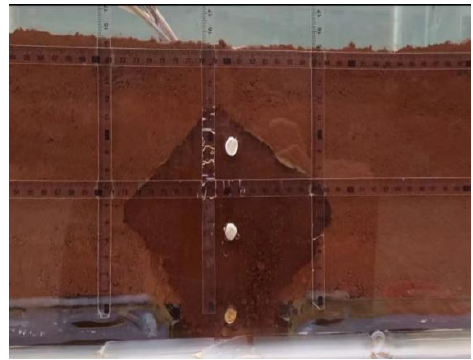
Figure 13. Cavity altarpiece.